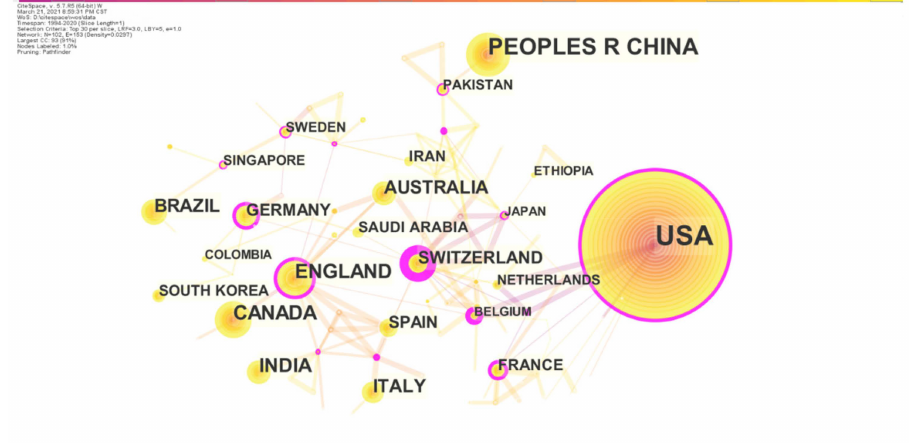
Figure 4. Co-Country/Region network (1994–2020). A node corresponds to a country or region. The larger the node, the more papers a country or region has published. The thicker the line between the nodes, the closer the two countries or regions work